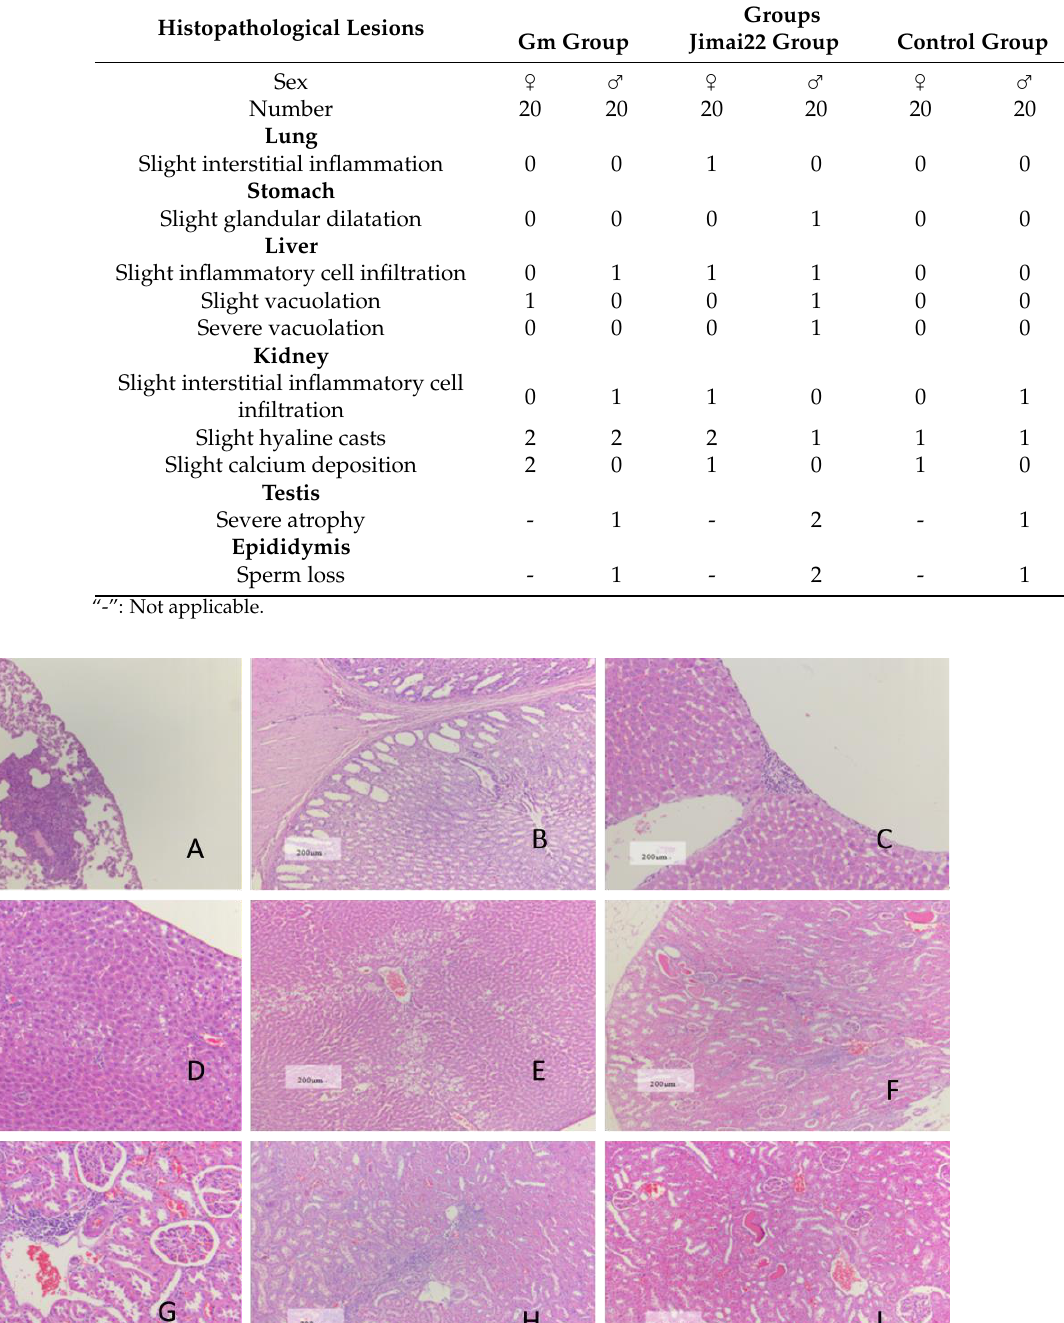
Table 5. Histopathological results of three groups at week 13.